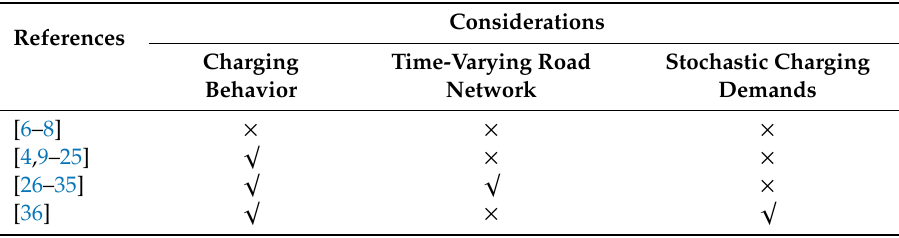
Table 1. Previous studies with respect to their